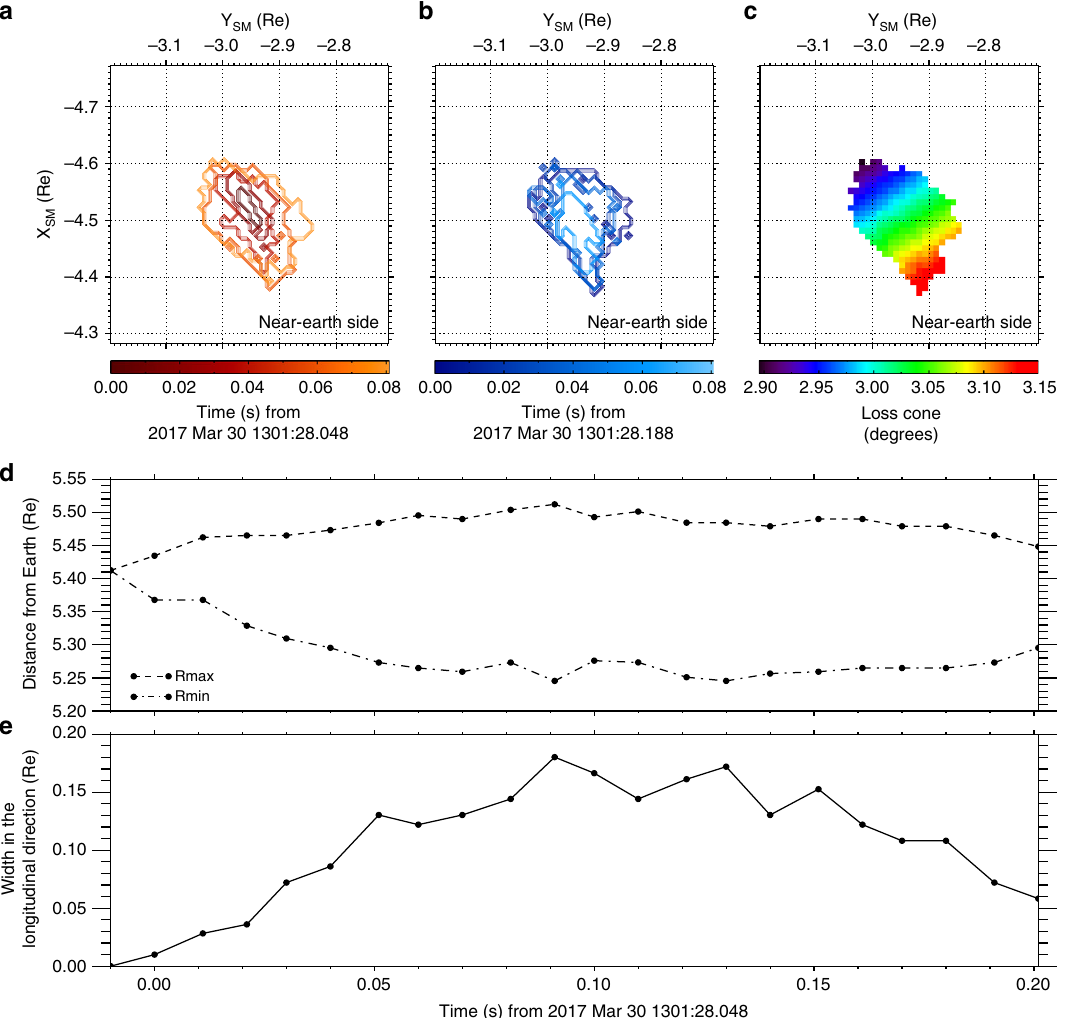
Fig. 5 Visualization of the region of resonant interaction between a single chorus wave and electrons. a The expansion (red contours) and b contraction (blue contours) of the chorus wave – particle interaction region at the magnetic equator ( Z SM = 0) in SM coordinates. Contour lines are plotted every 20 ms. c The spatial dependence of the equatorial loss cone calculated from the T02 model. The time variations of d the maximum and minimum radial distance from the Earth and e the width in the longitudinal direction of the resonant interaction